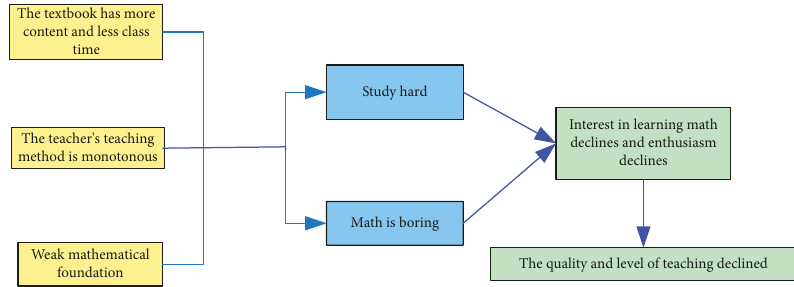
Figure 3: The impact of the existing instructing